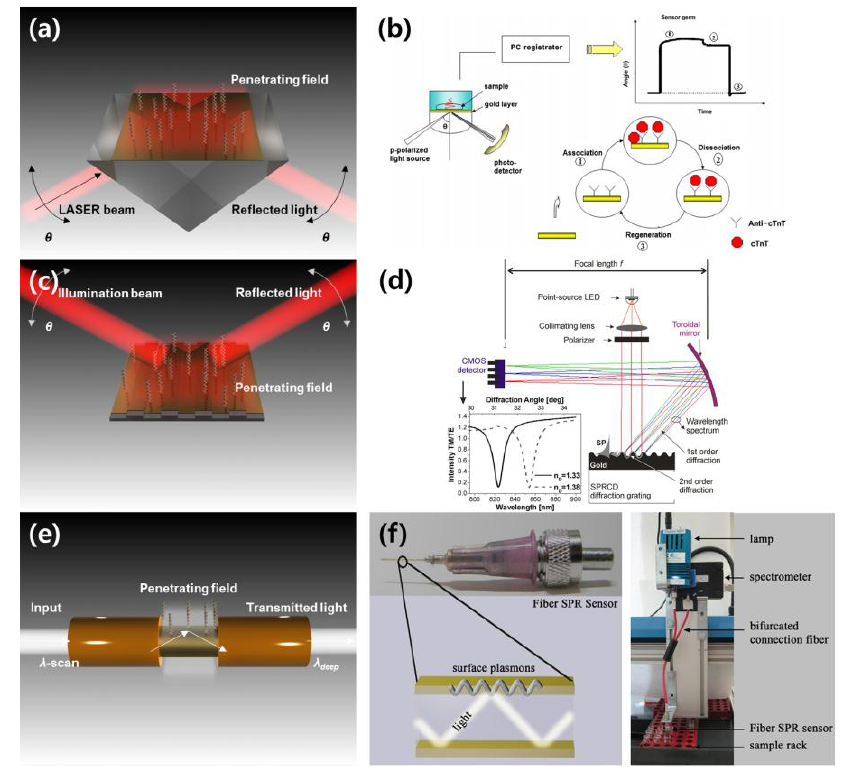
Figure 1a. Because there is a difference in the distance between the metal layer and the prism surface on which TIR occurs, Kretschmann configuration-based SPR sensors normally have a higher efficiency than Otto configuration-based sensors [45].